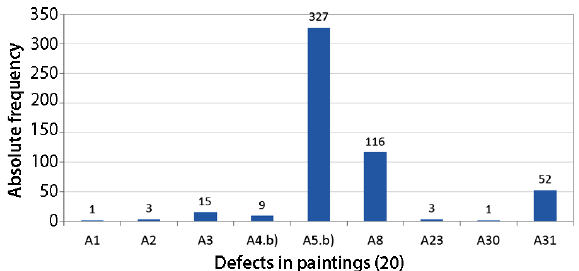
Fig. 19. Absolute frequency of defects in paintings (20)